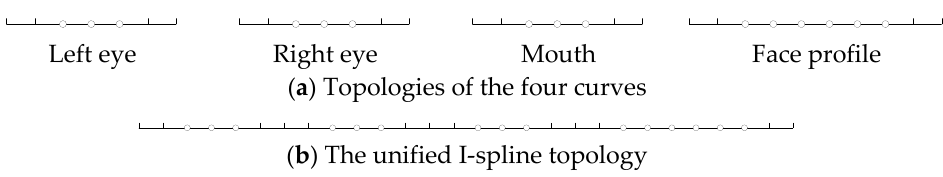
Figure 11. Unified representation of the B-spline curves of the face model.